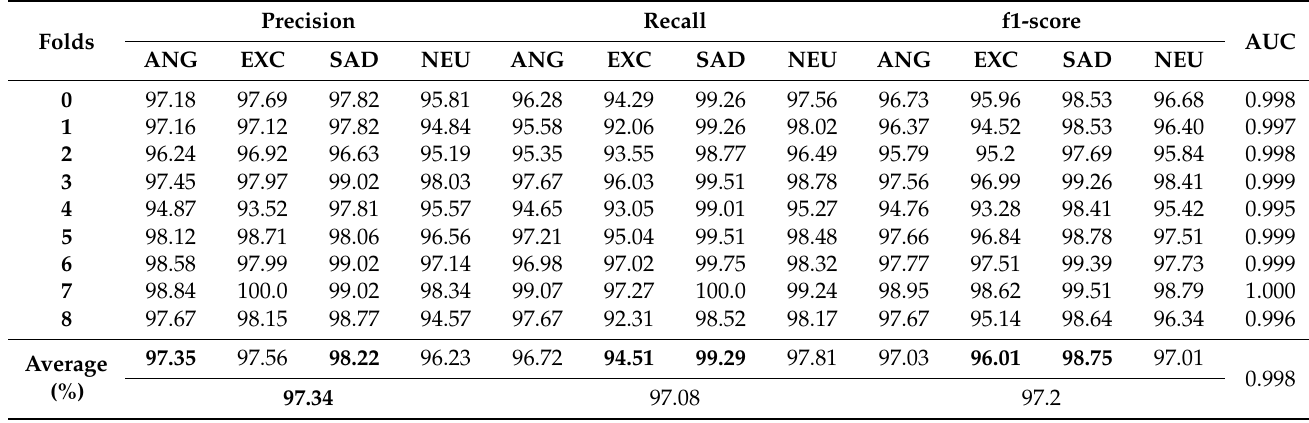
Table 10. Precision, recall, f1-score, and AUC for CRNN model with 128 parameters. Precision Folds